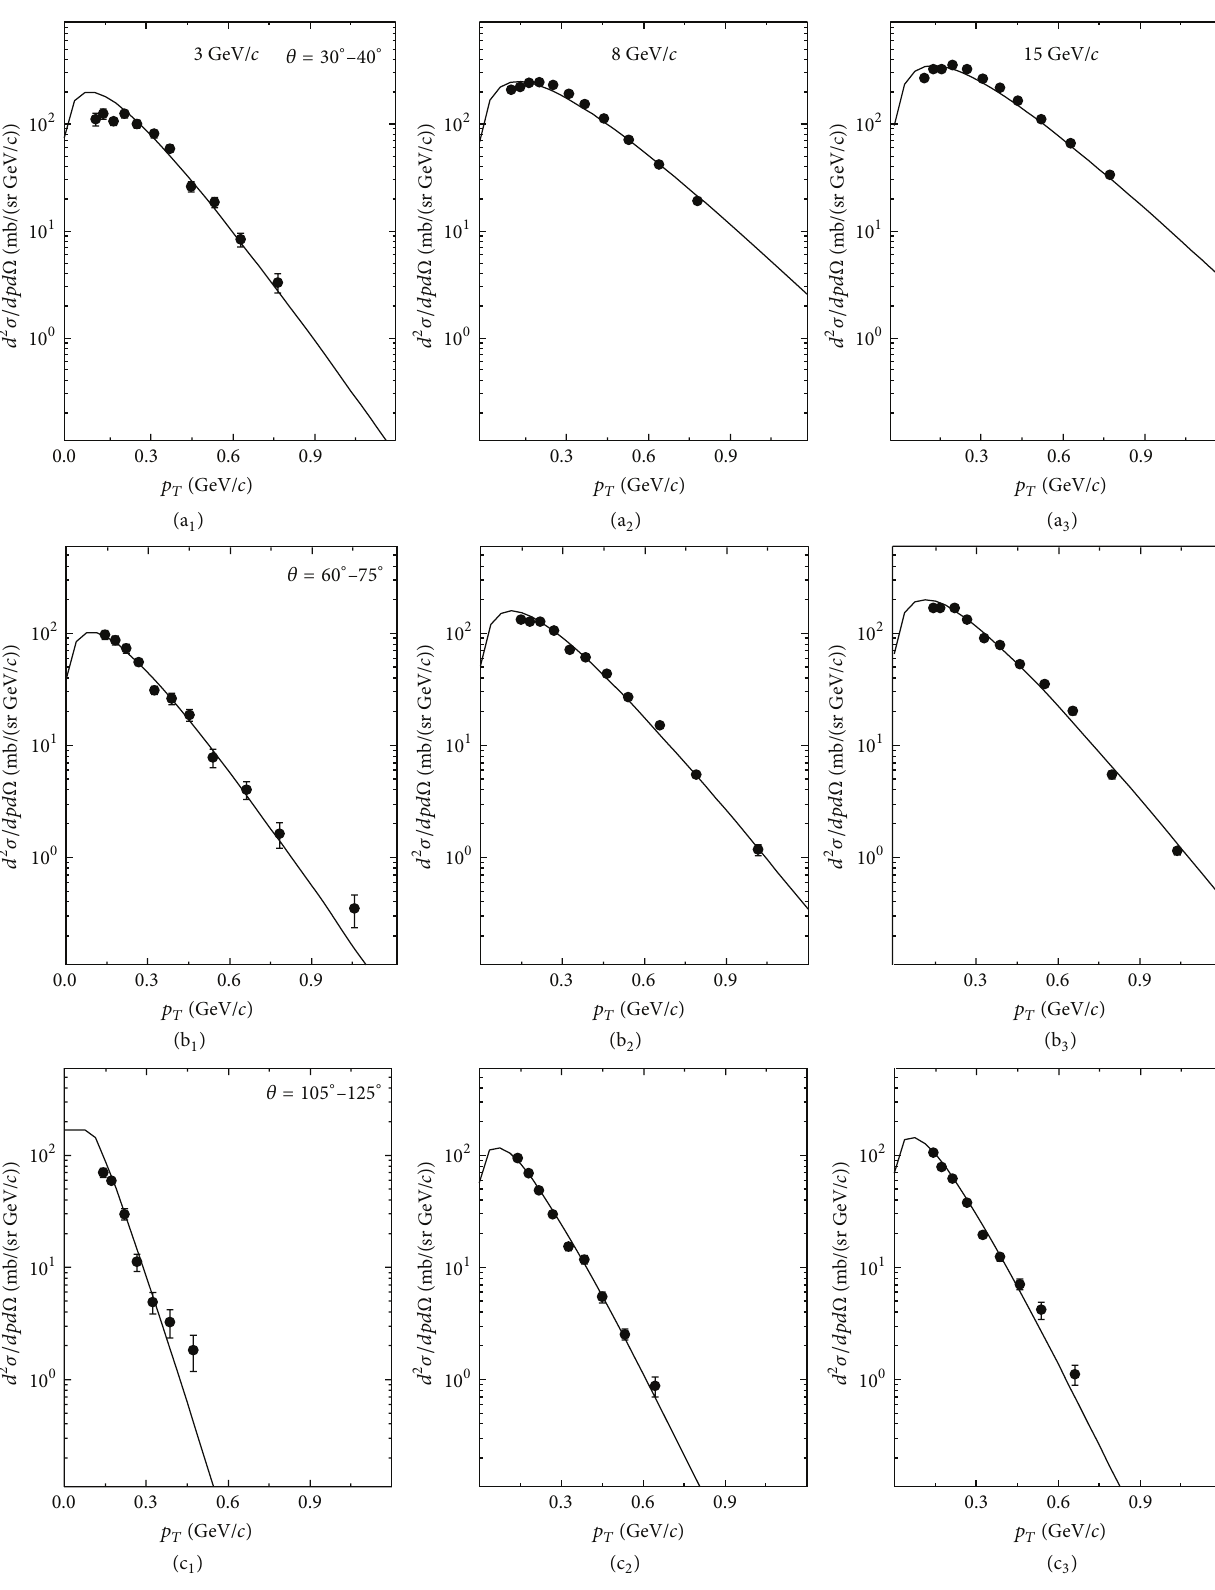
Figure 3: The same as Figure 1, but for 𝜋 +